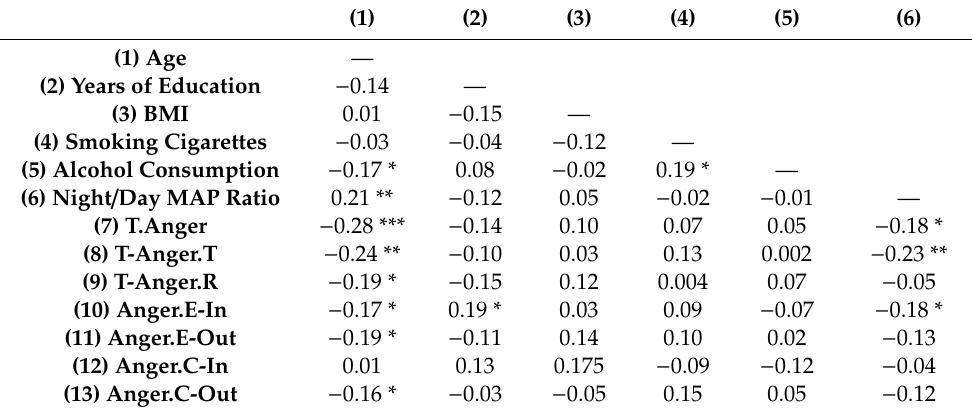
Table 2. Correlation (Pearson’s r) among dipping ratio, age, cigarette consumption, and anger scores (the p values are shown in